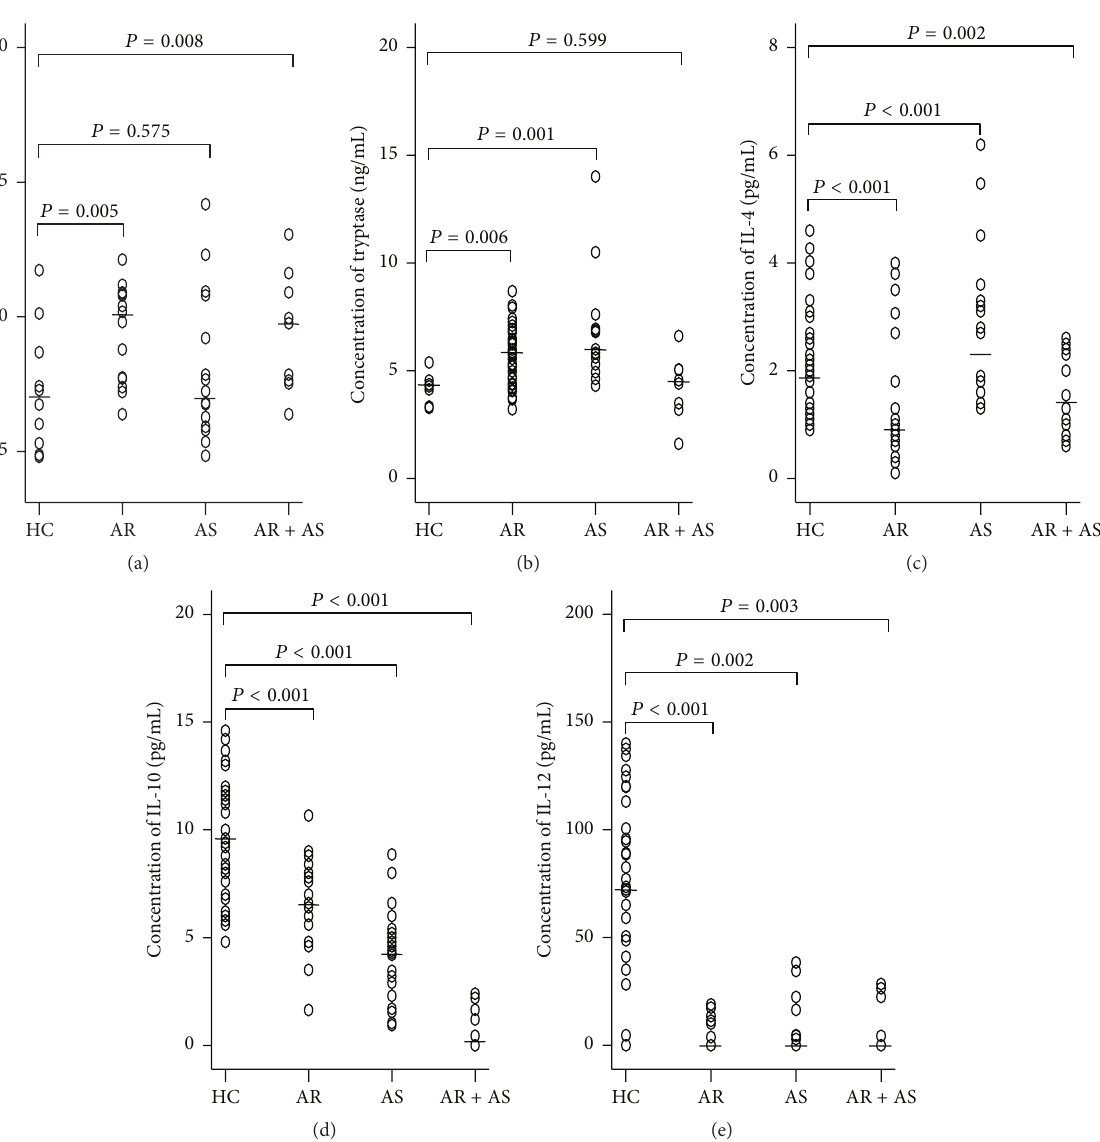
Figure 1: Scatter plots of the levels of IFN- 𝜆 2 (a), tryptase (b), IL-4 (c), IL-10 (d), and IL-12 (e) in the plasma of the patients with allergic rhinitis (AR), asthma (AS), and combined AR and asthma (AR + AS) and healthy control subjects (HC). Each symbol represents the value from one subject. The median value is indicated with a horizontal line. 𝑃 < 0.05 was taken as statistically